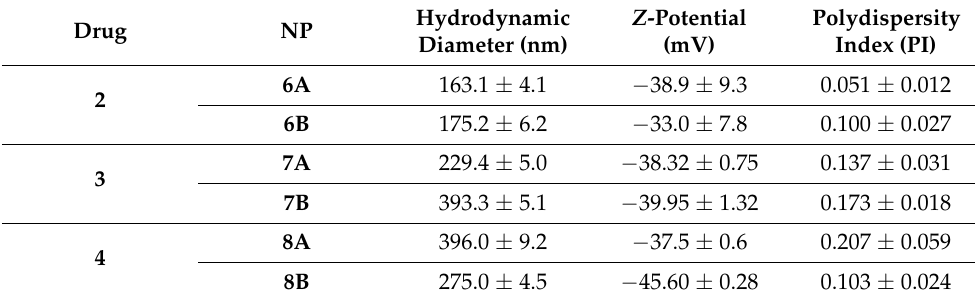
Table 1. Hydrodynamic diameter and Z -potential of nanoformulations 6–8A,B .